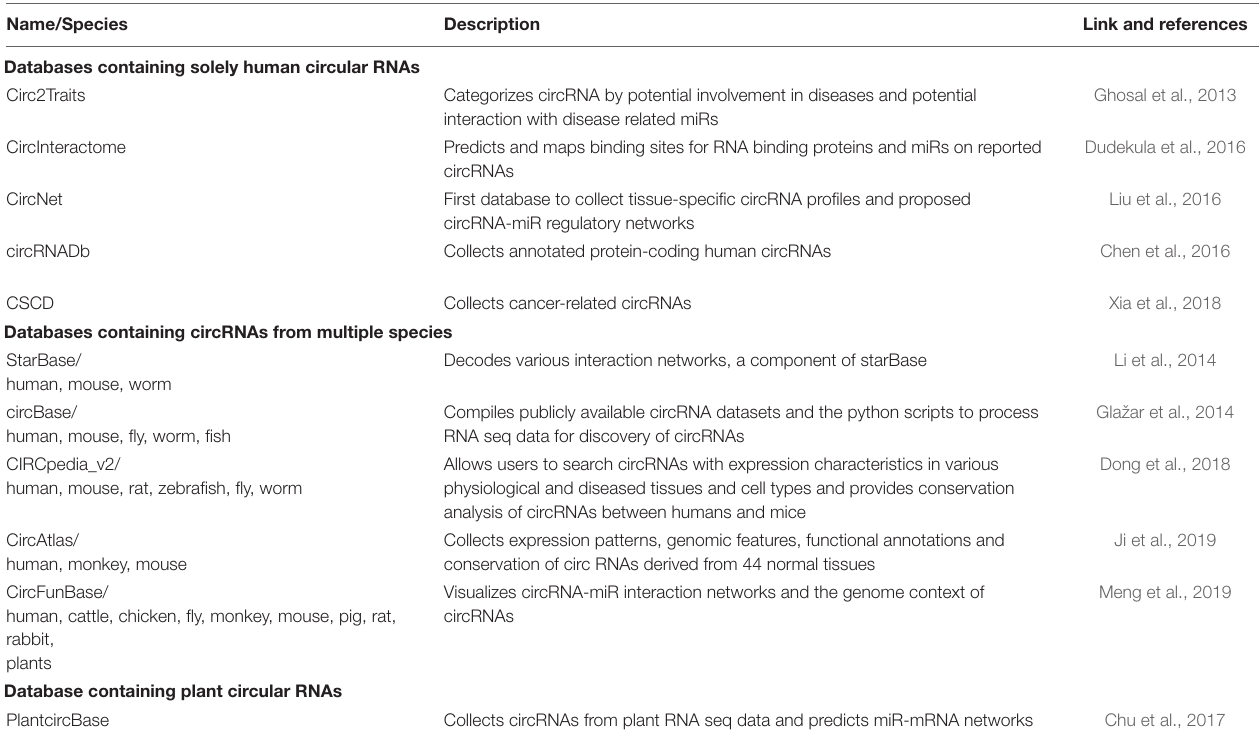
TABLE 2 | Overview of publicly available circular RNA